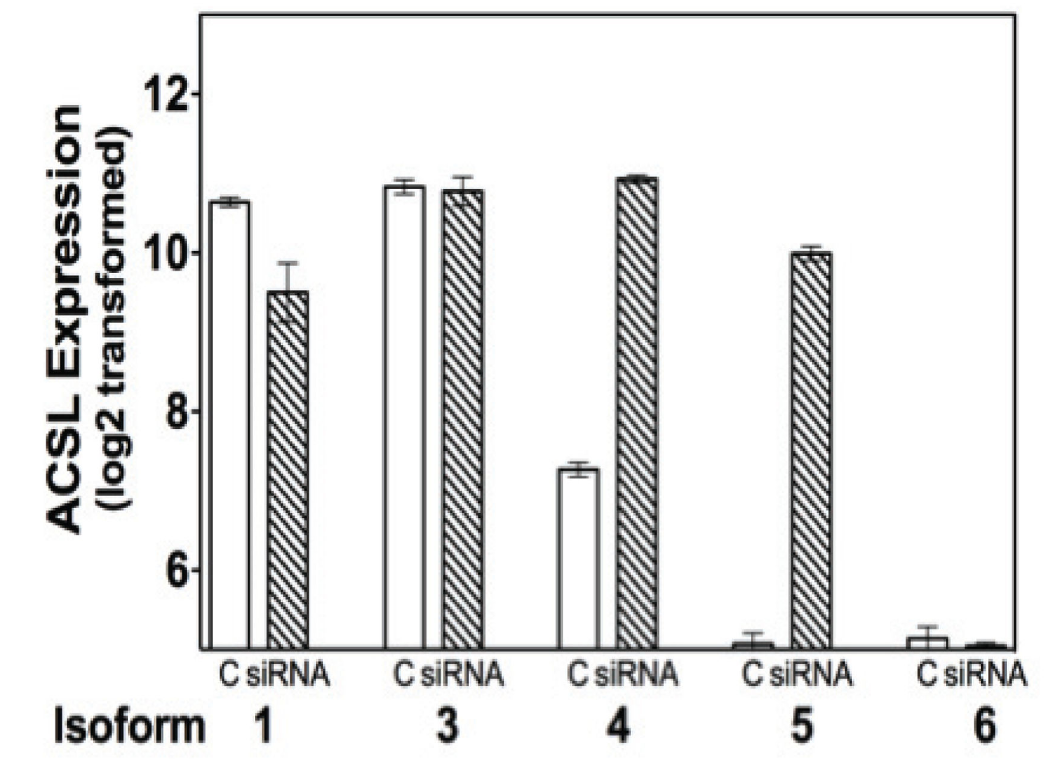
Figure 5. Effect of ablation of ERα on ACSL4 expression in MCF-7 cells. siRNA-was utilized to mediate the silencing of ER expression in MCF-7 cells as described in reference [31]. The results shown are taken from an Affymetrix Human Genome U133 plus 2.0 Gene Chip microarray study reported on the Gene Expression Omnibus (GDS40610). Values shown represent the means ± 1SD of triplicate determinations. The significance of the differences for isoform 1, p=4.53E-03, for isoform 4, p=5.02E-07, and for isoform 5, p=9.67E-07. No significant difference is observed for isoforms 3 and 6. doi: